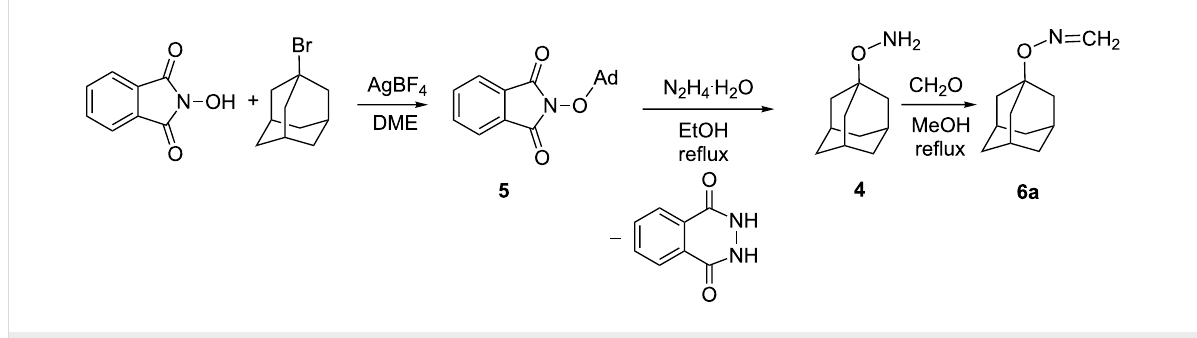
Scheme 2: Preparation of adamantyloxyamine ( 4 ) and its conversion into N -(adamantyloxy)formaldimine ( 6a ); Ad = 1-adamantyl.